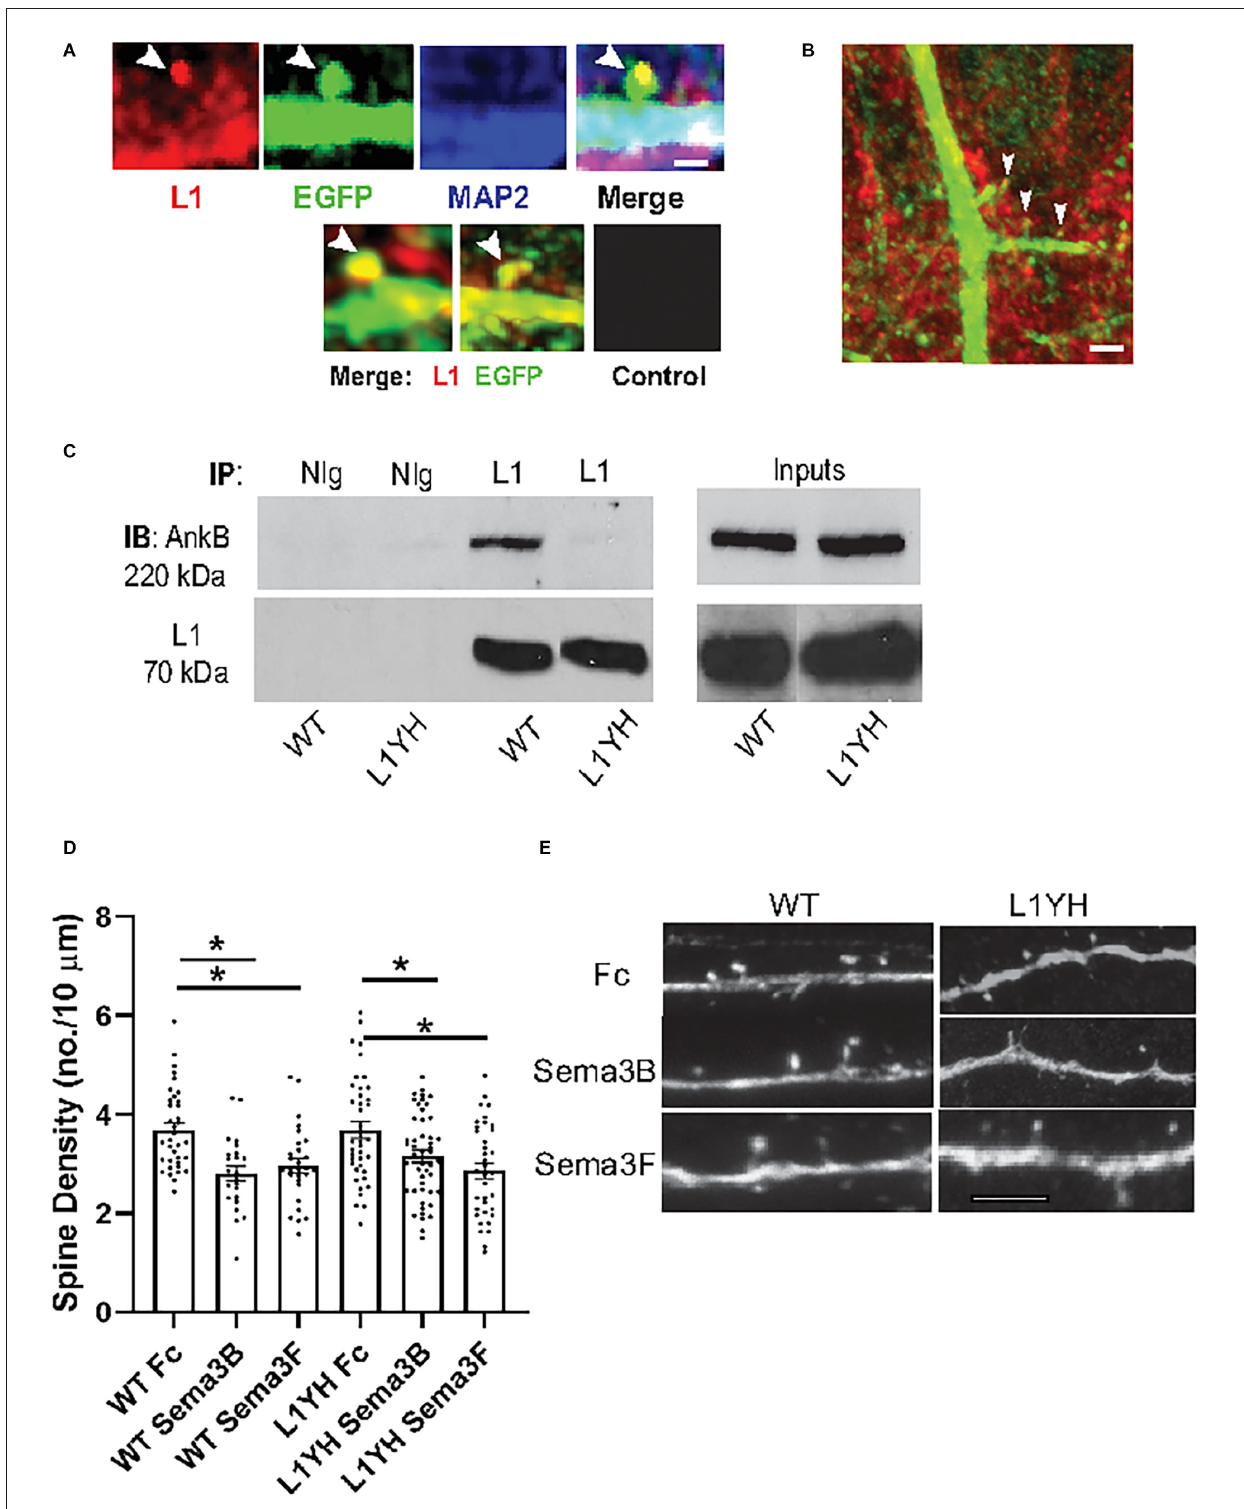
FIGURE3 L1 immunofluorescent localization and association with Ankyrin B in mouse neocortex. (A) Confocal images of L1 immunofluorescence labeling (red) in spine heads (arrows) and adjacent dendritic shafts labeled for the somatodendritic marker MAP2 (blue) are shown in PFC layer 2/3 pyramidal neurons of WT Nex1Cre-ERT2:RCE mice expressing EGFP (green). The merged image shows the overlap of L1 and EGFP in spine heads (yellow, arrow), and overlap of L1, EGFP, and MAP2 (white) in dendrites with a patchy distribution. Scale bar = 1 µ m. Lower panels show additional merged images of L1 and EGFP immunostaining in spines (arrows) and dendrites. Control staining with secondary antibodies alone is shown in a merged image of PFC layer 2/3 pyramidal neurons in Nex1Cre-ERT2:RCE mice. (B) Immunofluorescence labeling of L1 (red) and EGFP (green) in a merged confocal image of spines and dendrites from a representative layer 2/3 pyramidal neuron of WT Nex1Cre-ERT2:RCE PFC.